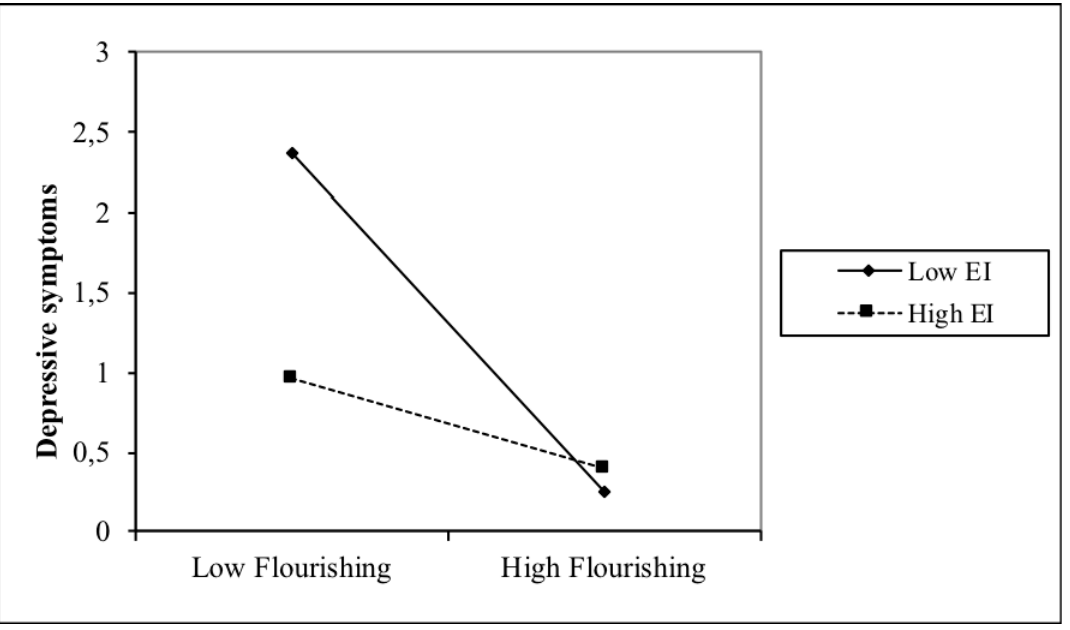
Figure 2. Interaction between EI and flourishing with regards to depressive symptoms.